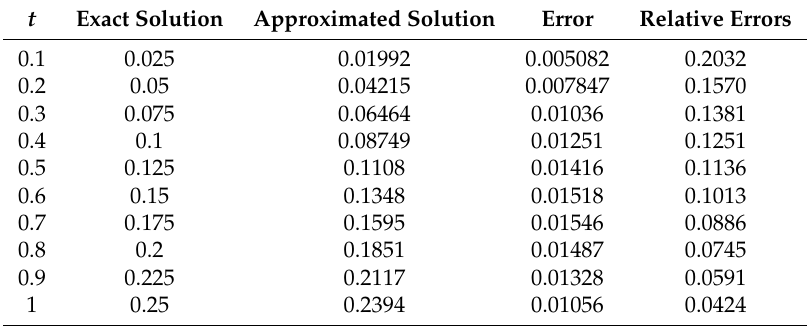
Table 2. Comparing Approximated and second component of exact solution with error.